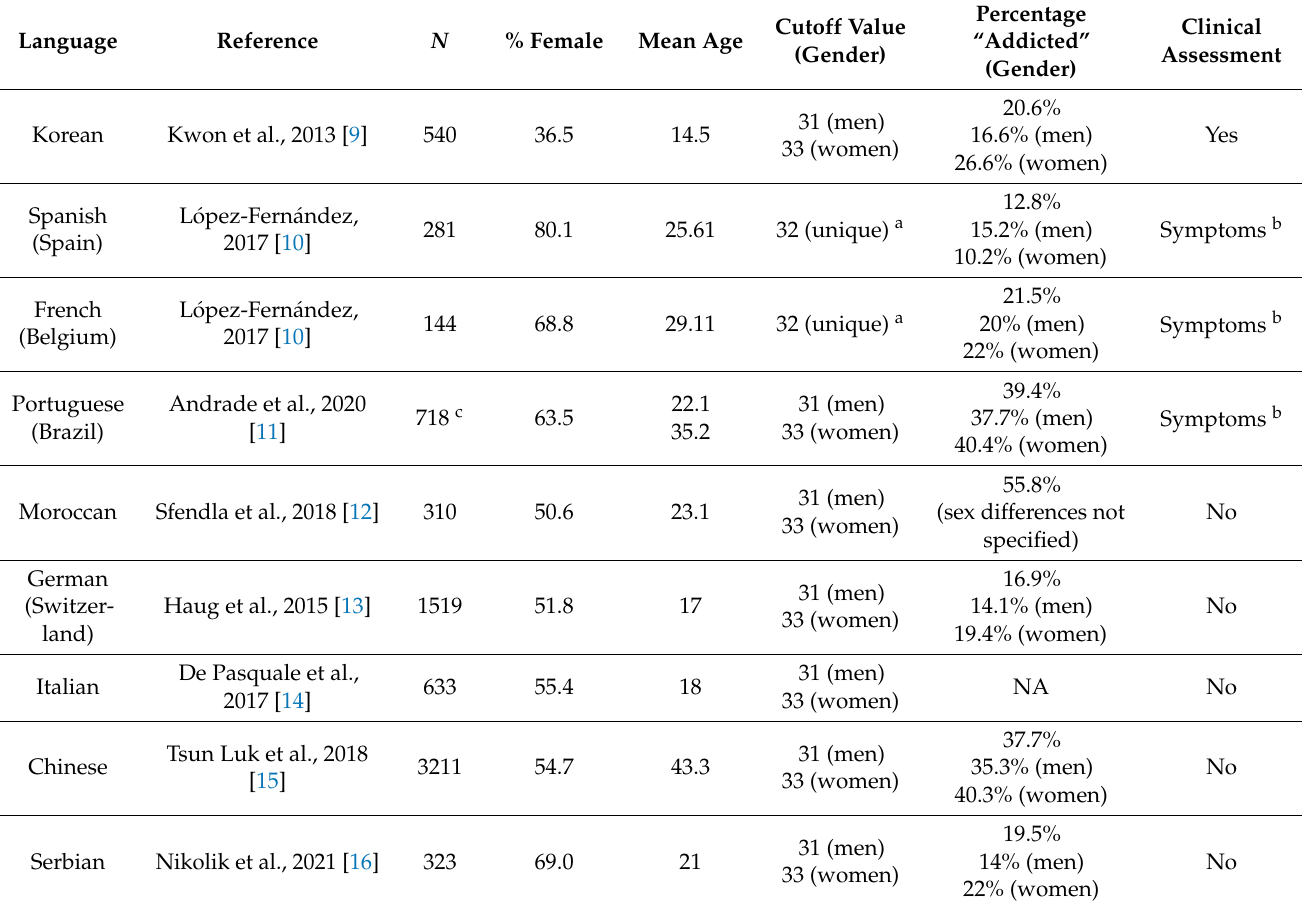
Table 1. Characteristics of the SAS-SV in nine different language